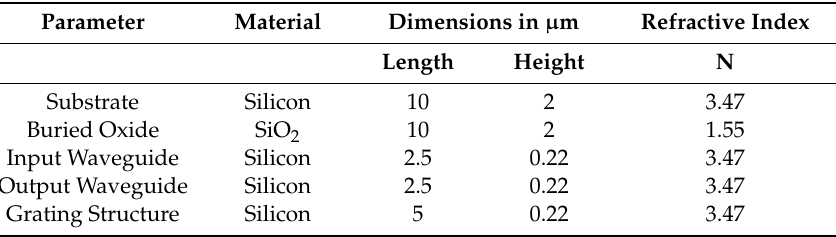
Figure 3. Front views of the SOI grating coupler: ( a ) without a PDMS microfluidic channel and ( b ) with a PDMS microfluidic channel.